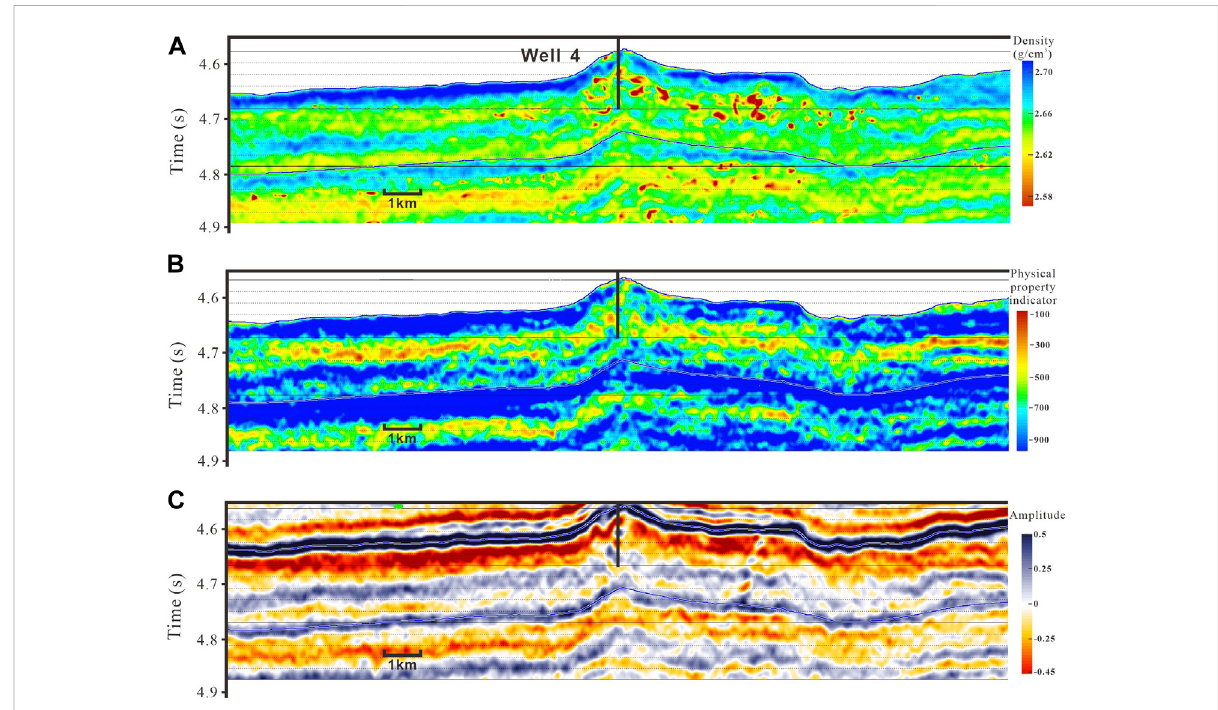
Pro fi les along the N – S direction of Well 4 of (A) density, (B) the physical property indicator, and (C) stack seismic traces.